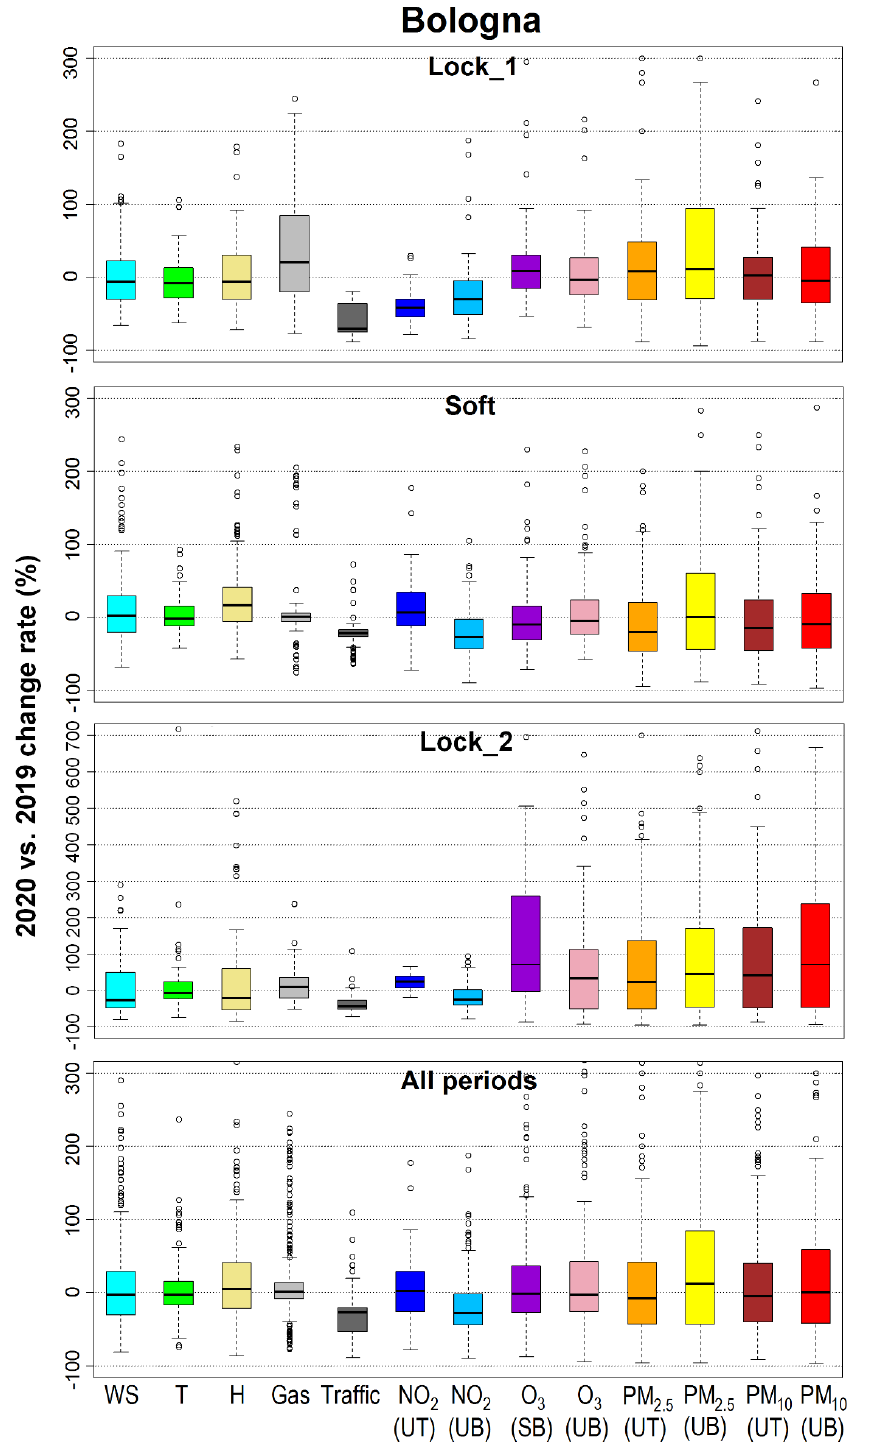
Figure 4. Boxplots by period of 2020 vs. 2019 change rates of daily observations in Bologna: concen- trations by station type of NO 2 , O 3 , PM 2.5 , and PM 10 ; wind speed ( WS ); air temperature ( T ); PBL height ( H ), gas consumption; road traffic. Boxplots are delimited by the first ( Q 1 ) and third ( Q 3 ) distribution’s quartiles, while the black line inside the box denotes the median value ( Q 2 ). Lower whisker is Q 1 − 1.5*IQR , while upper whisker is Q 3 + 1.5*IQR , where the interquartile range ( IQR ) is Q 3 − Q 1 . Circles outside the whiskers denote outlier data.